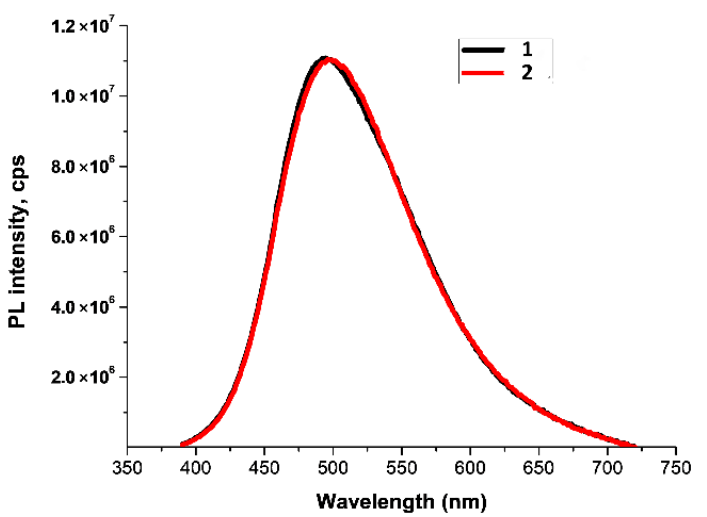
Figure 16. PL spectra of hydrophobic BoronLightSil samples with different concentrations of TMCS: (1) 3% for BLS-0.05-HB-3 sample and (2) 5% for BLS-0.05-HB-5 sample.